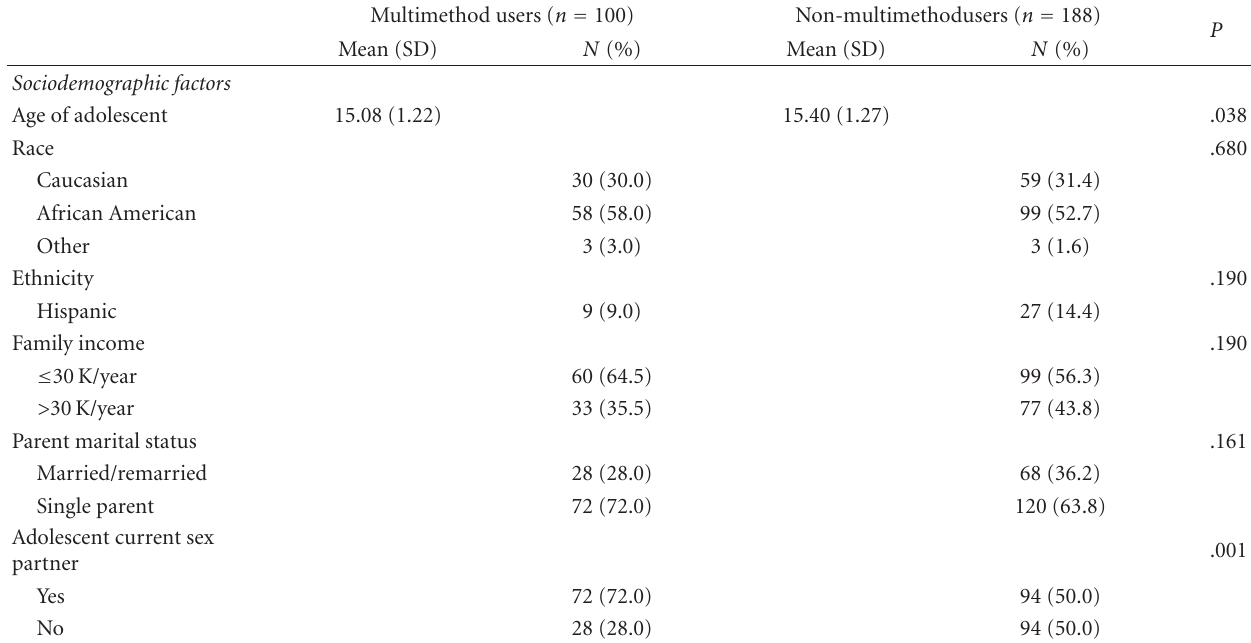
Table 1: Characteristics of multimethod and non-multimethod users. Multimethod users ( n = 100)